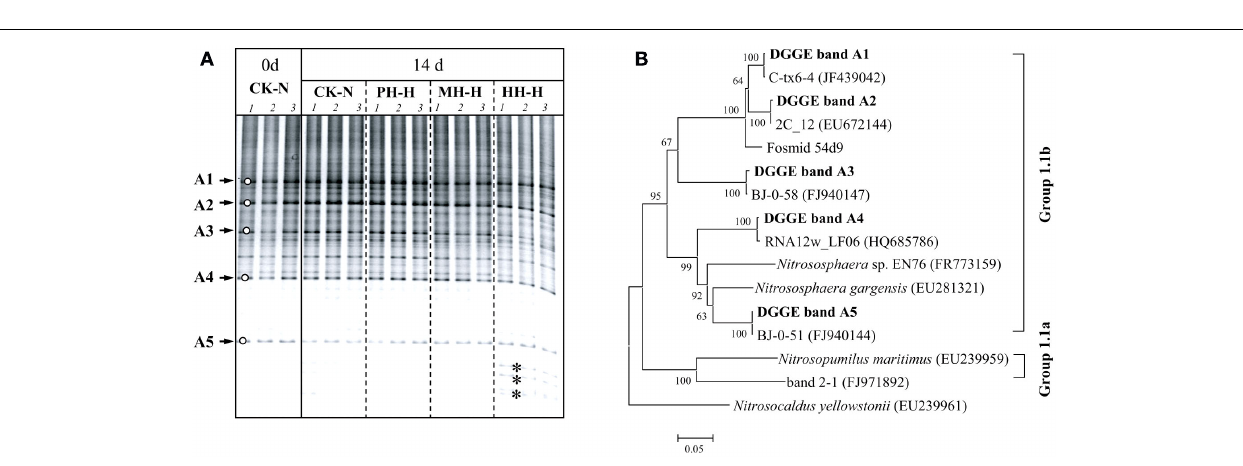
FIGURE 4 | Denaturing gradient gel electrophoresis fingerprints (A) and phylogenetic tree (B) of archaeal amoA gene in soil